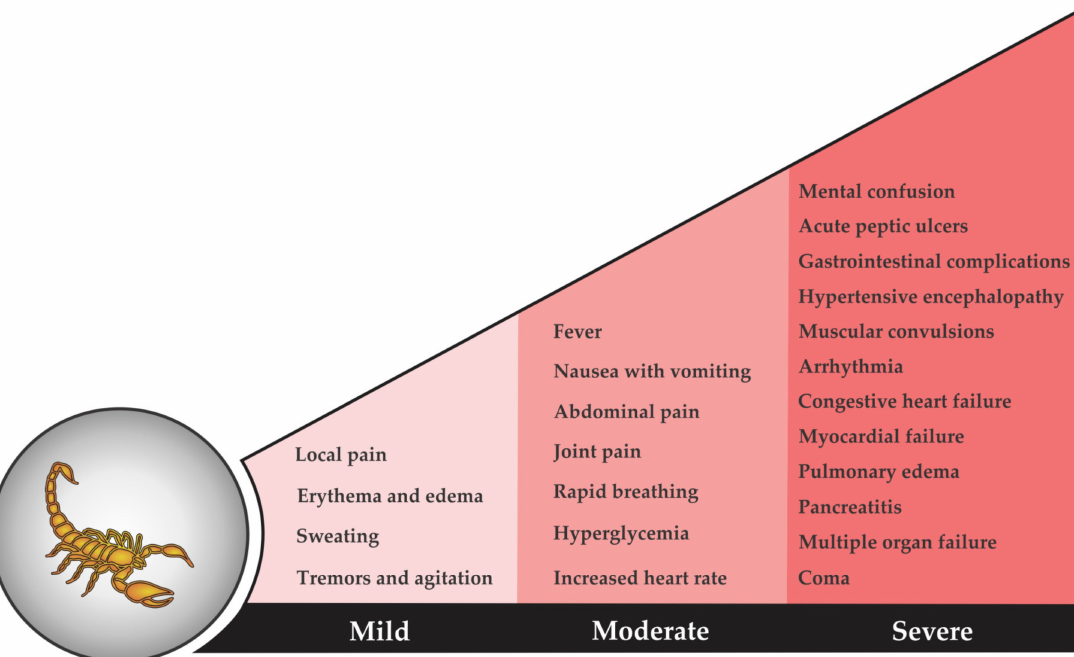
Figure 2. Clinical manifestations and symptoms of mild, moderate, and severe scorpion envenomings. Typical symptoms of mild stings last for minutes to hours and include great local pain, a reddened and swollen site of sting (erythema and edema), numbness, sweating, body tremors, and agitation. More intense stings from scorpions with venom containing cytolytic toxins may result in blood blisters, hemorrhages, and necrosis of the surrounding tissue. In moderate envenoming cases, the body additionally reacts with fever, abdominal and joint pain, hyperglycemia, abnormally rapid breathing, increased heart rate, and nausea with vomiting. These symptoms can reside for days and are mostly caused by neurotoxins: Na + , K + , and Ca 2 + ion channel modulators. Neurotoxins can also cause severe envenomings, which can lead to cardiovascular, neurological, pulmonary, and / or gastrointestinal complications, such as pulmonary edema, myocardial failure, arrhythmia, congestive heart failure, extreme muscular convulsion, hypertensive encephalopathy, acute peptic ulcers, pancreatitis and lethal multiple organ failure, mental confusion, and coma. After several days, most victims of lethal scorpion stings die from cardiac or respiratory